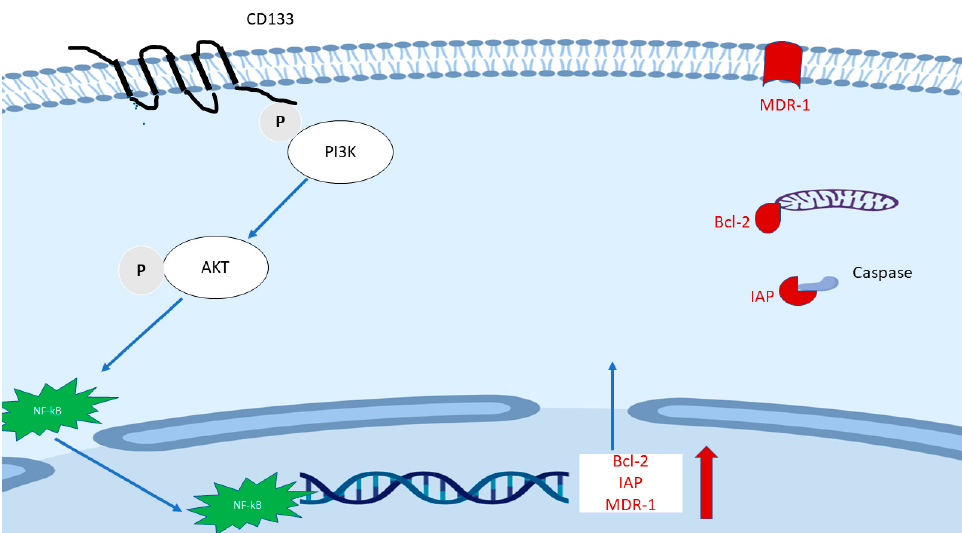
Figure 3. The proposed main mechanism of the role of CD133 in treatment resistance. The phos- phorylated tyrosine 828 of CD133 mediates direct interaction with p85 of phosphoinositide 3-kinase (PI3K), followed by phosphorylated AK and translocation of NF- κ B/p65. The latter enhances the transcription of Bcl-2, some members of the Inhibitors of Apoptosis Proteins (IAPs) family and mul- tidrug resistance 1 (MDR-1).